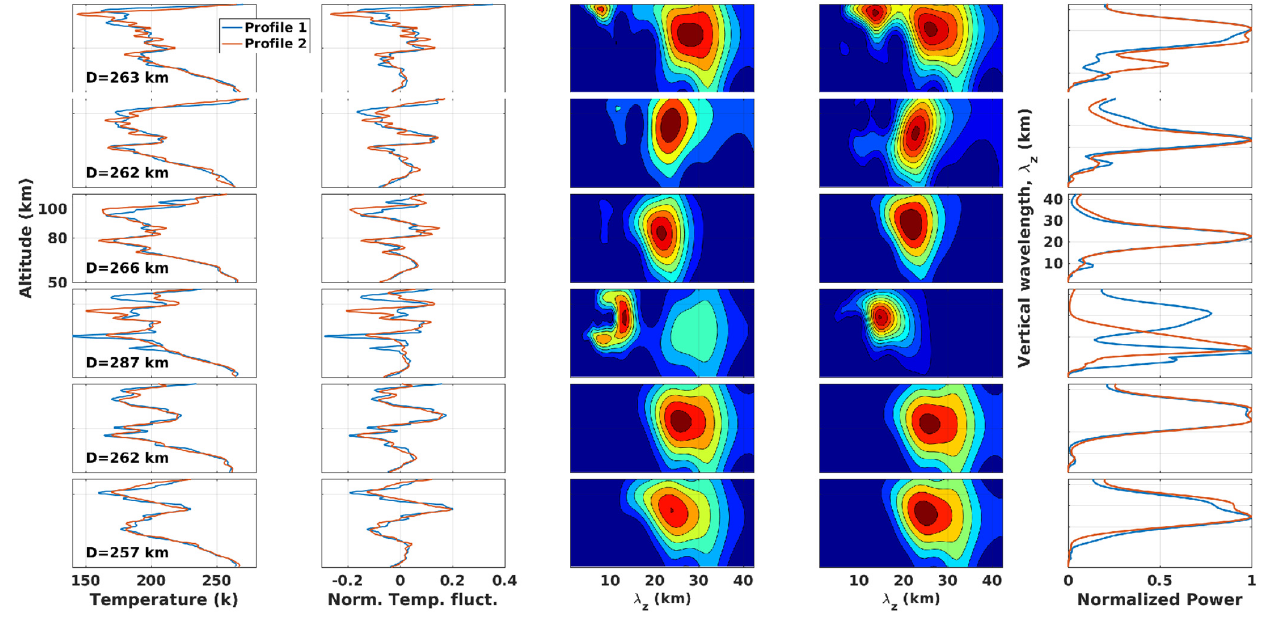
Figure 4. Temperature profiles ( left panels ), normalized temperature fluctuations ( 2nd column from the left ), contour maps of WPS versus vertical wavelength and altitude for the two profiles ( 3rd and 4th columns from the left , deep red and blue colors represent respectively the dominant and lowest power), and normalized GWPS versus vertical wavelength ( right column ) corresponding to six orbits of SABER satellite on 15 October 2011.